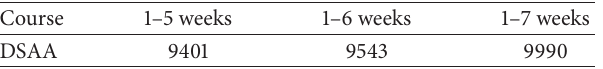
Table 3: Number of